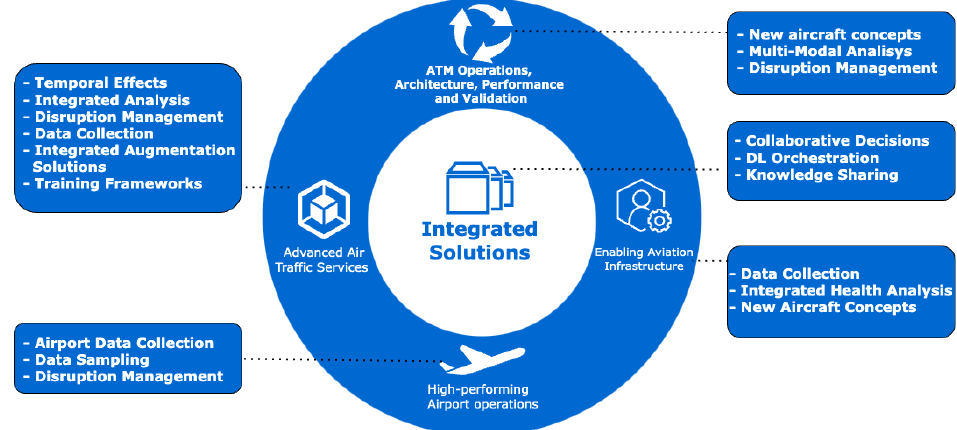
Figure 11. Open challenges: ATM